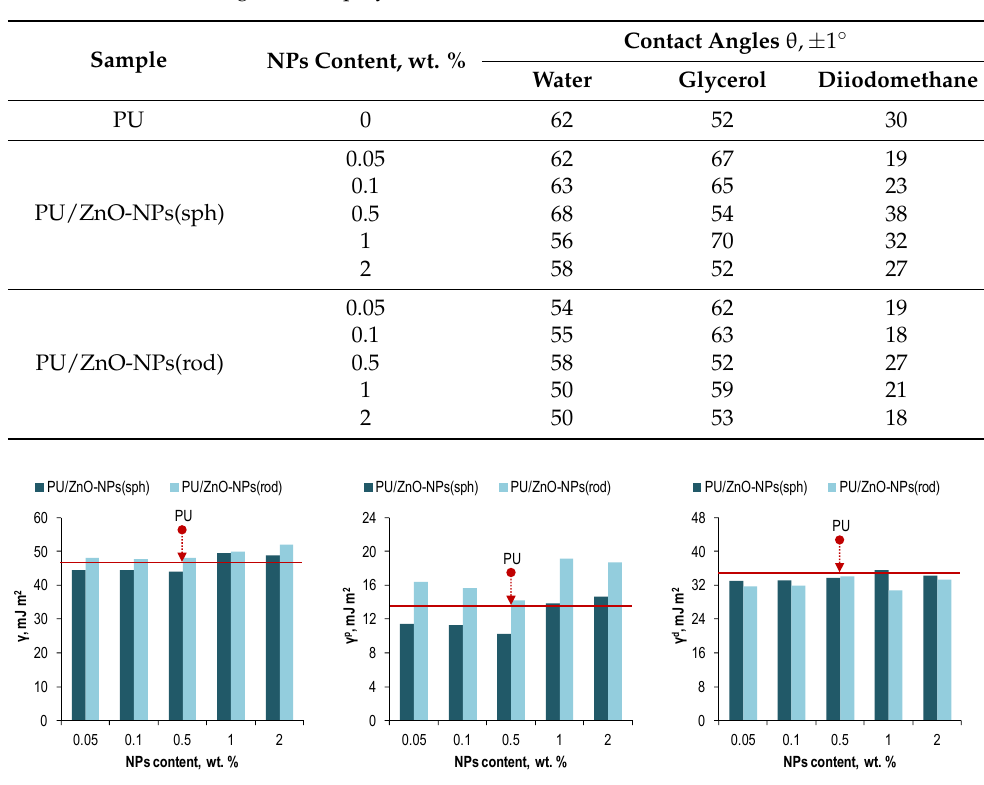
Figure 5. The specific surface free energy (overall ( left ), polar ( center ), and dispersive ( right )). With loading spherical ZnO-NPs into the PU matrix, a decrease in the polar surface energy component was observed with a minimum at 0.5 wt. % of the NPs. The same minimum was observed with loading the rod-shaped ZnO-NPs. However, the maximum values slightly exceeded the values of the polar energy for the pure PU membrane. At the same time, the dispersion surface energy component in the case of both NPs’ types decreased with respect to the pure PU membrane. Such tendency might be due to